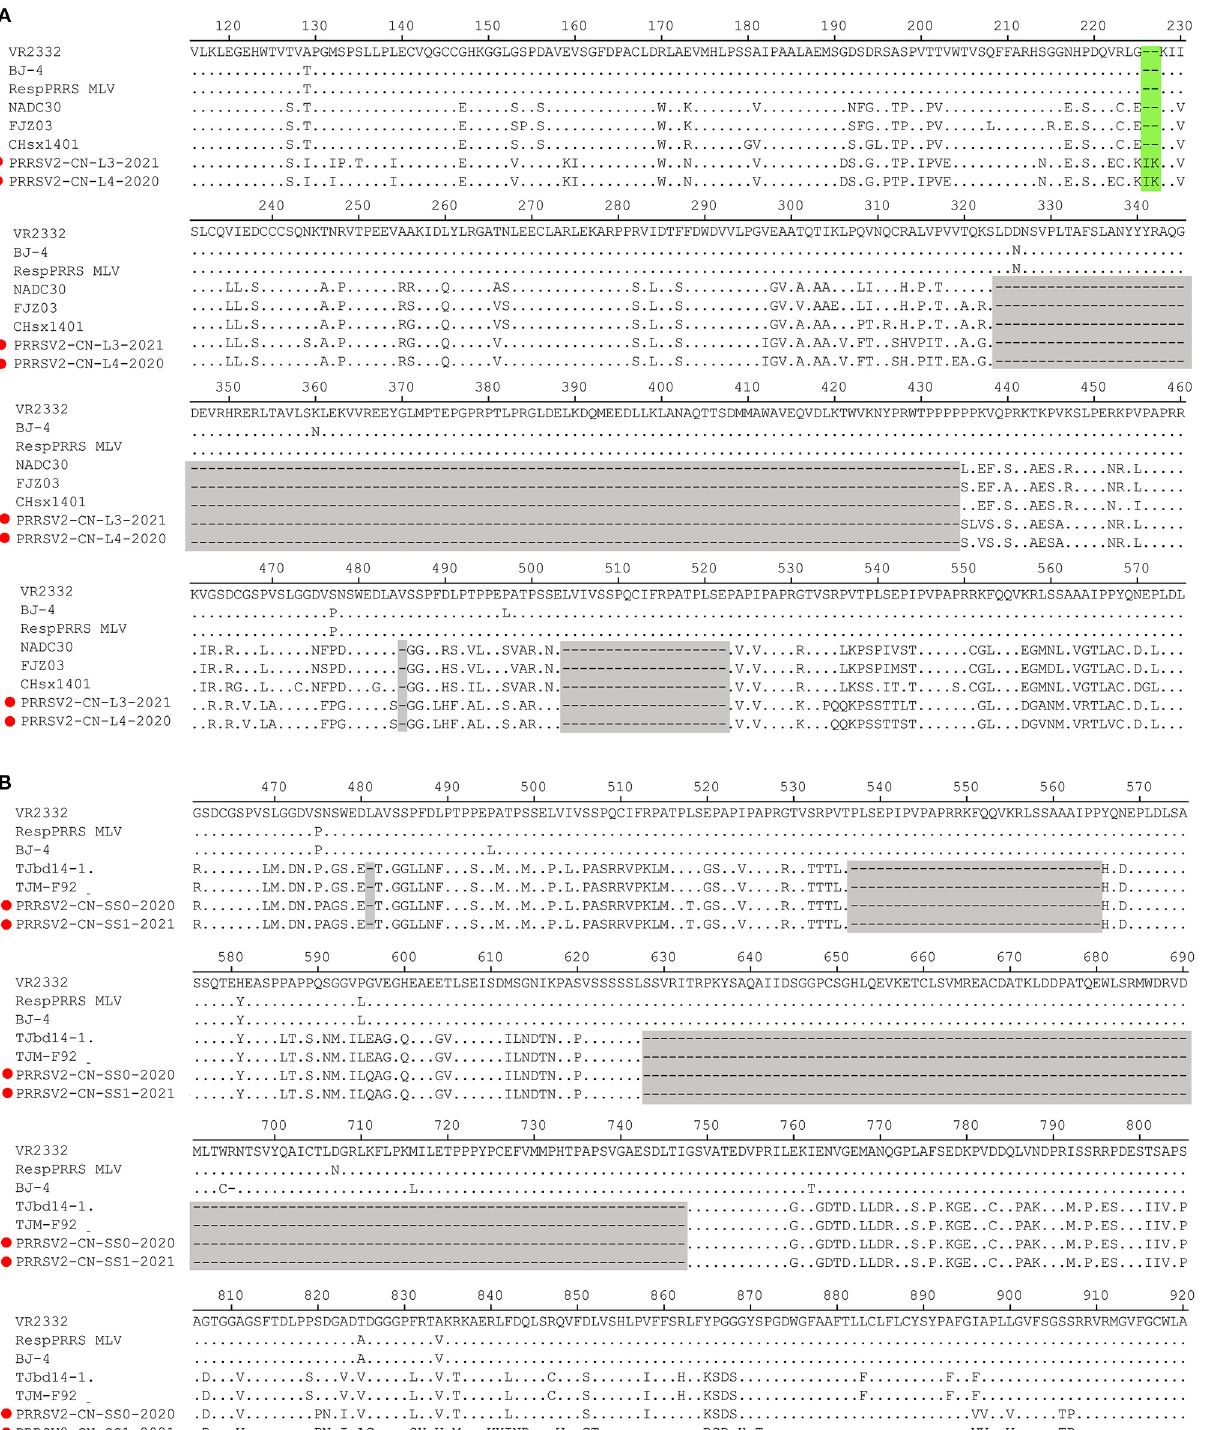
Frontiers in Veterinary Science |